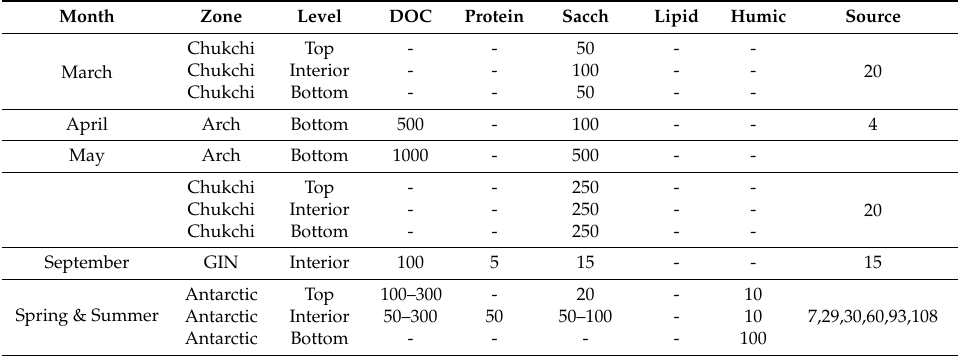
Table 3. Summary of composition for measured bulk organic carbon in brine (micromolar carbon), mainly at established research stations. A compilation of analogous Antarctic values is included for comparison. Polymers, oligomers and the associated monomers are considered together for the proteins and carbohydrates. Blanks may carry information down from the set just above. Except for DOC, values are agnostic toward phase state. Abbreviations: (DOC) dissolved organic carbon, (Sacch) Polysaccharide or fresh carbohydrate, (Arch & GIN as in earlier